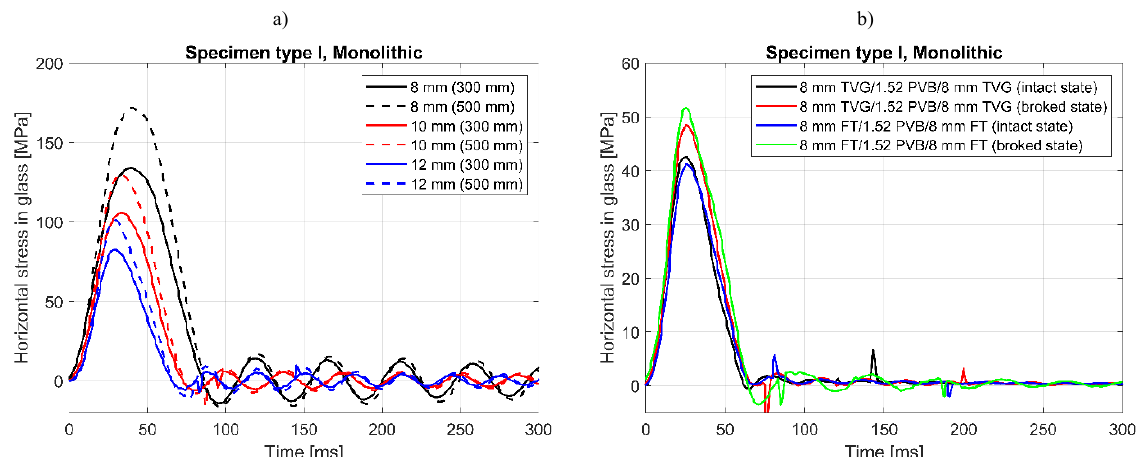
Fig. 6 Stress in glass for monolithic (a) and laminated (b) panels under soft-body impact (TVG – heat strengthened glass, FT – fully toughened